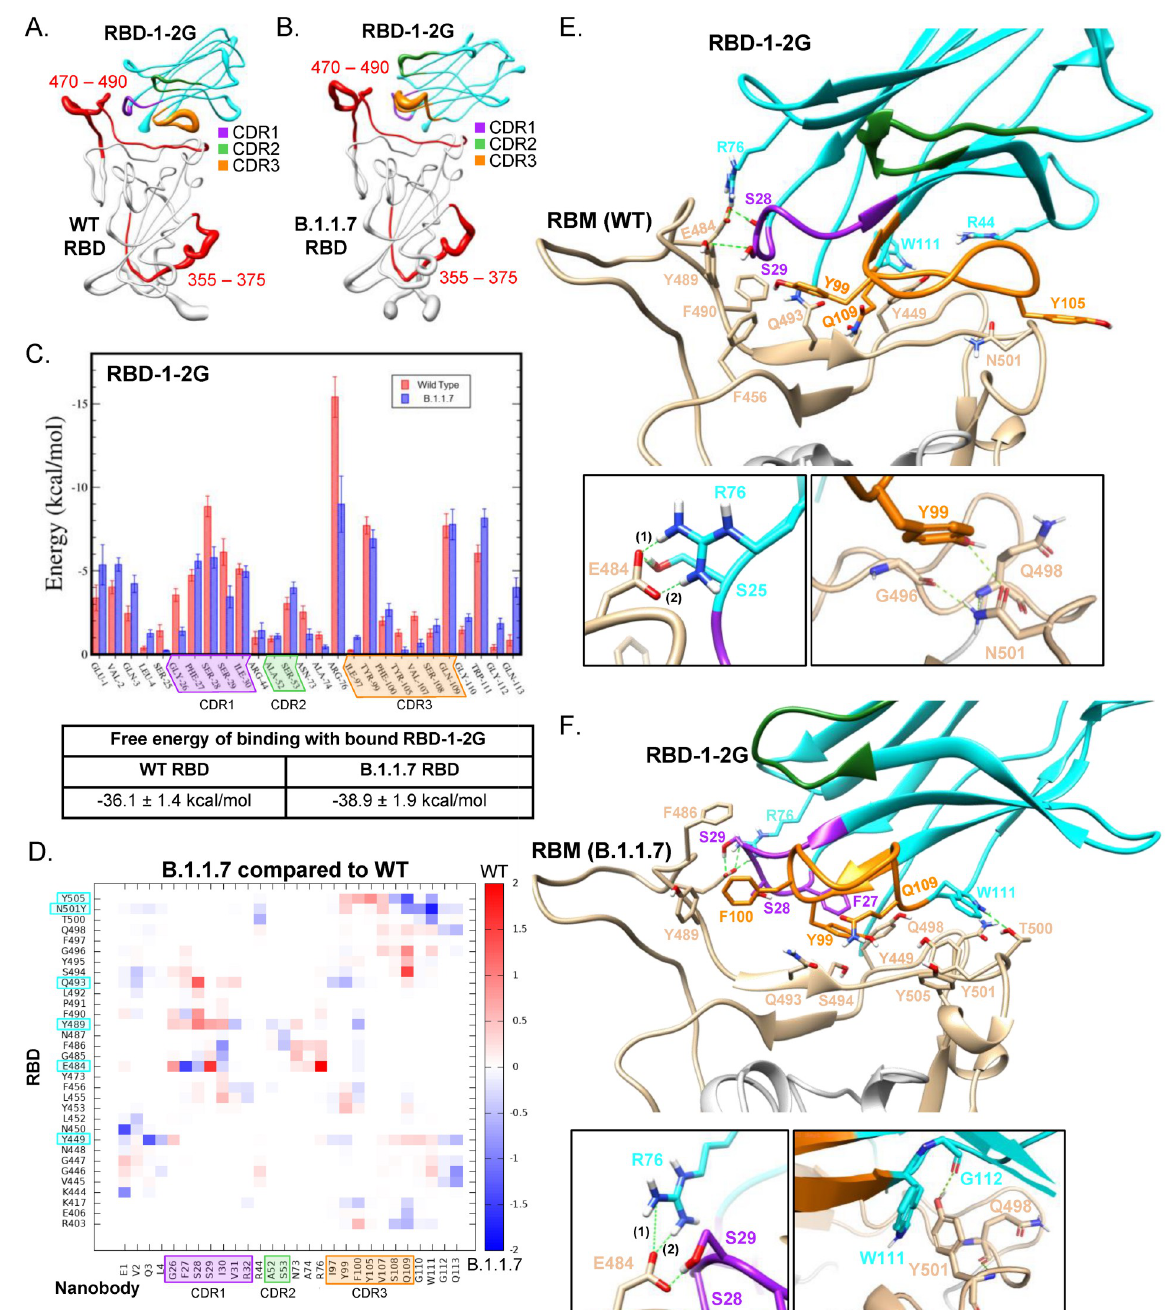
Fig 5. Molecular dynamics of RBD-1-2G with Wild type and B.1.1.7 RBD variant. (A-B) Sausage plot representation of RBD-1-2G in complex with (A)WT RBD and (B) B.1.1.7 RBD. The most flexible regions are indicated in red. (C) Free Energy of binding contribution of each Nb residue in complex with the RBD WT and B.1.17 variant. (D) Heatmap comparing RBD-1-2G’s free energy of binding contributions against the B.1.1.7 and WT RBD. RBD residues that contributed greater than -5 kcal/mol are highlighted with cyan. (E-F) Atomic model obtained after the atomic model fitting and MD simulations of RBD-1-2G in complex with (E) WT RBD and (F) B.1.1.7 RBD.